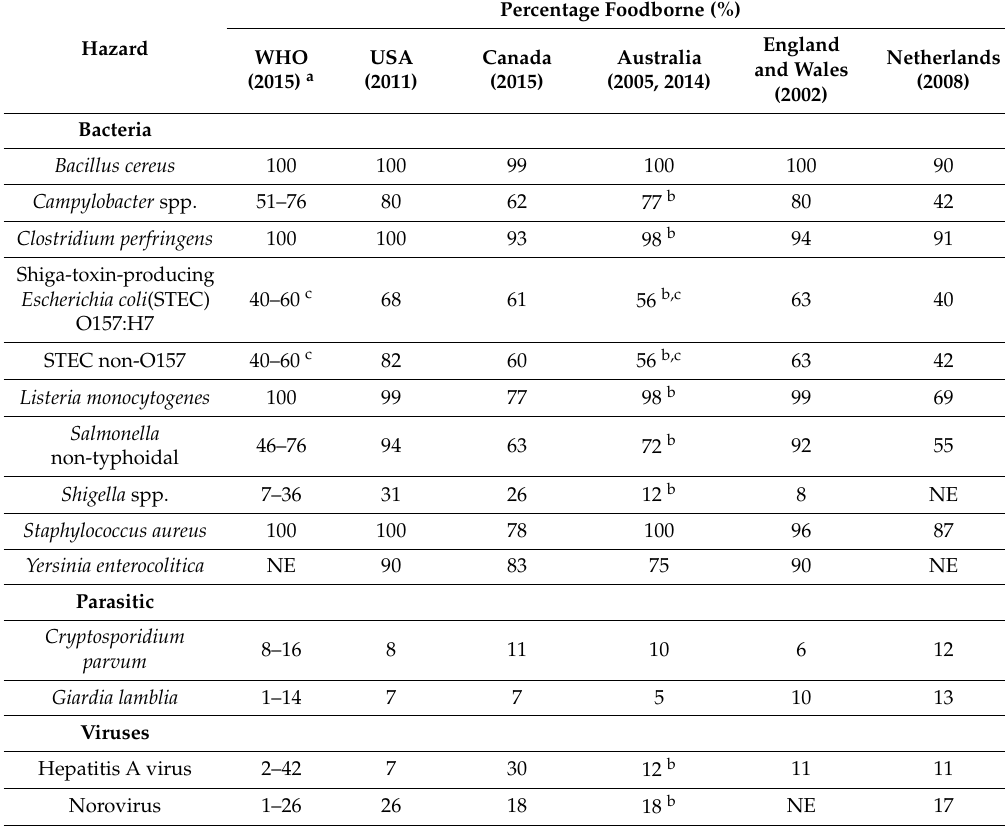
Table 1. The estimated foodborne illness due to different pathogens from a few countries